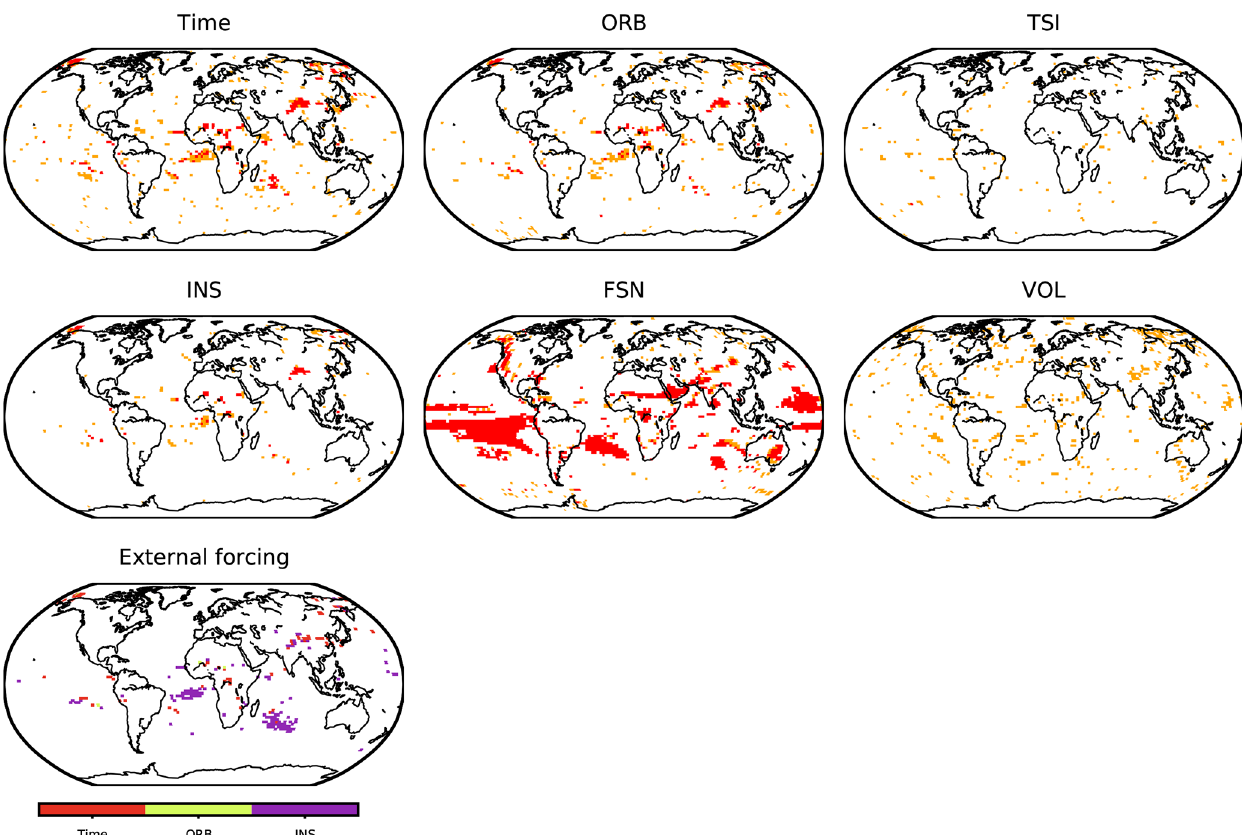
Figure 9. The external-forcing-GPD models that outperform the stationary GPD models at the 99% confidence interval based on the D statistics and explain better the variability of extreme precipitation. Orange shades indicate the regions where the D statistics in the full-forcing simulation are statistically significant and red shades where both full-forcing and orbital-only simulations present significant D statistics. Note that the VOL-covariate model is not generated for the orbital-only simulation. The corresponding plots for each of the simulations can be found in Figs. S5 and S6 in the Supplement. The lower panel of external forcing shows the best model among time-, ORB- and INS-covariate models by comparing the D statistics among these three